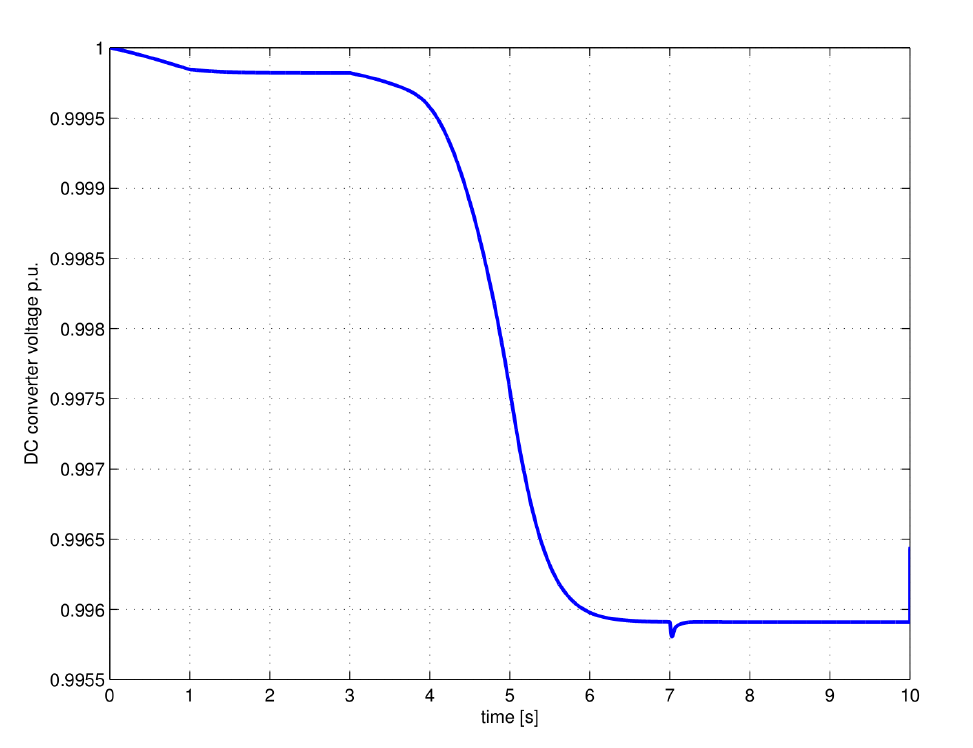
Figure 9. Variation of the DC Link voltage during the intervention of the control system.